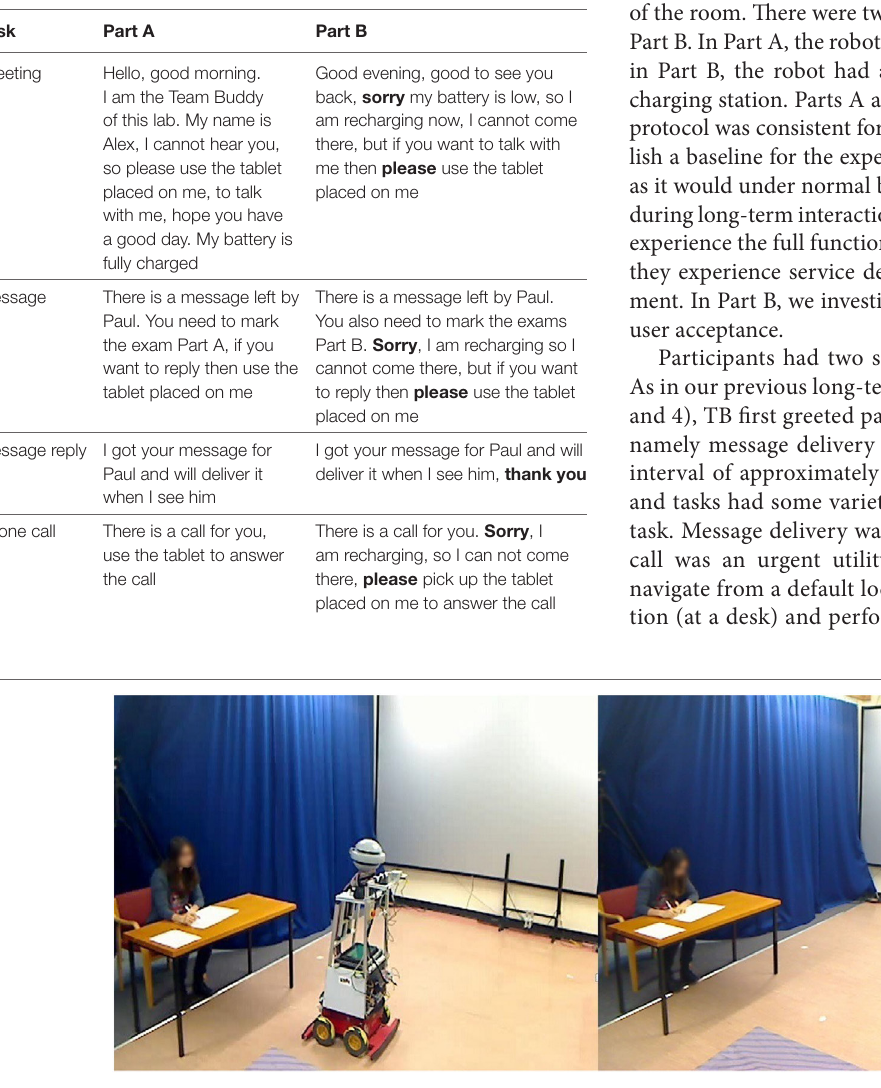
TaBle 2 | Condition 2: social verbal utterances.